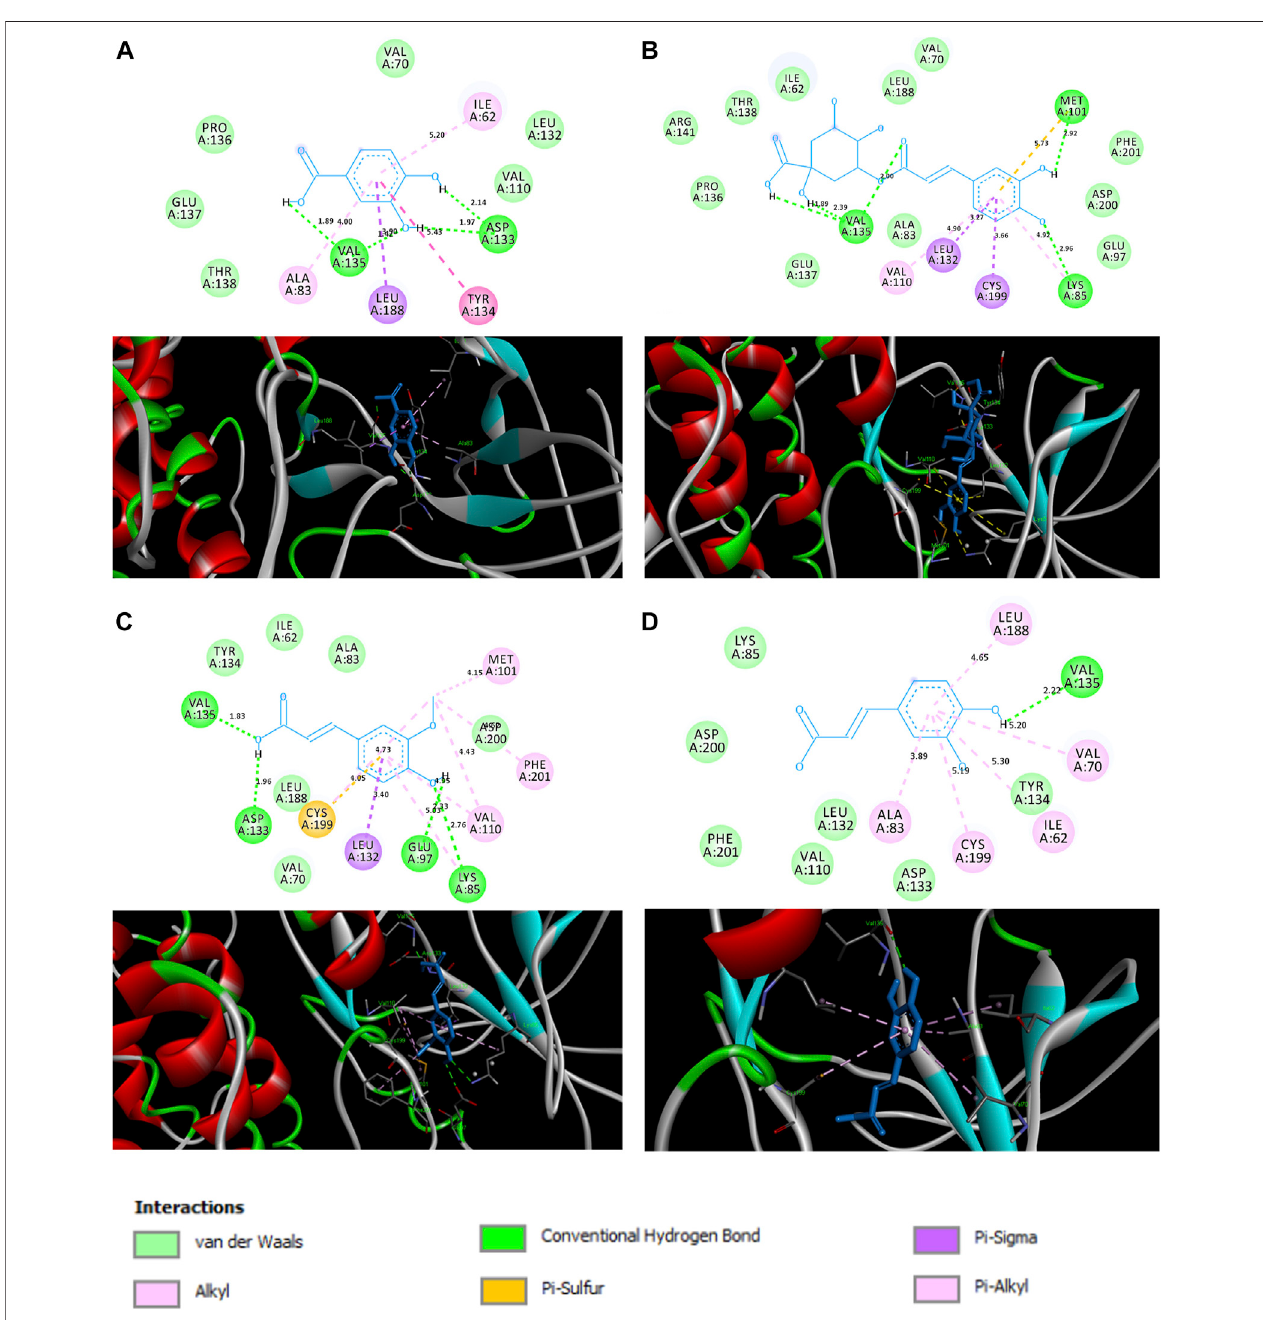
FIGURE 1 | Interactions between (A) protocatechuic acid, (B) chlorogenic acid, (C) ferulic acid and (D) caffeic acid, and the amino acids of the active site of GSK (PDB ID: 1Q5K) illustrated in 2D (top) and 3D (bottom) .